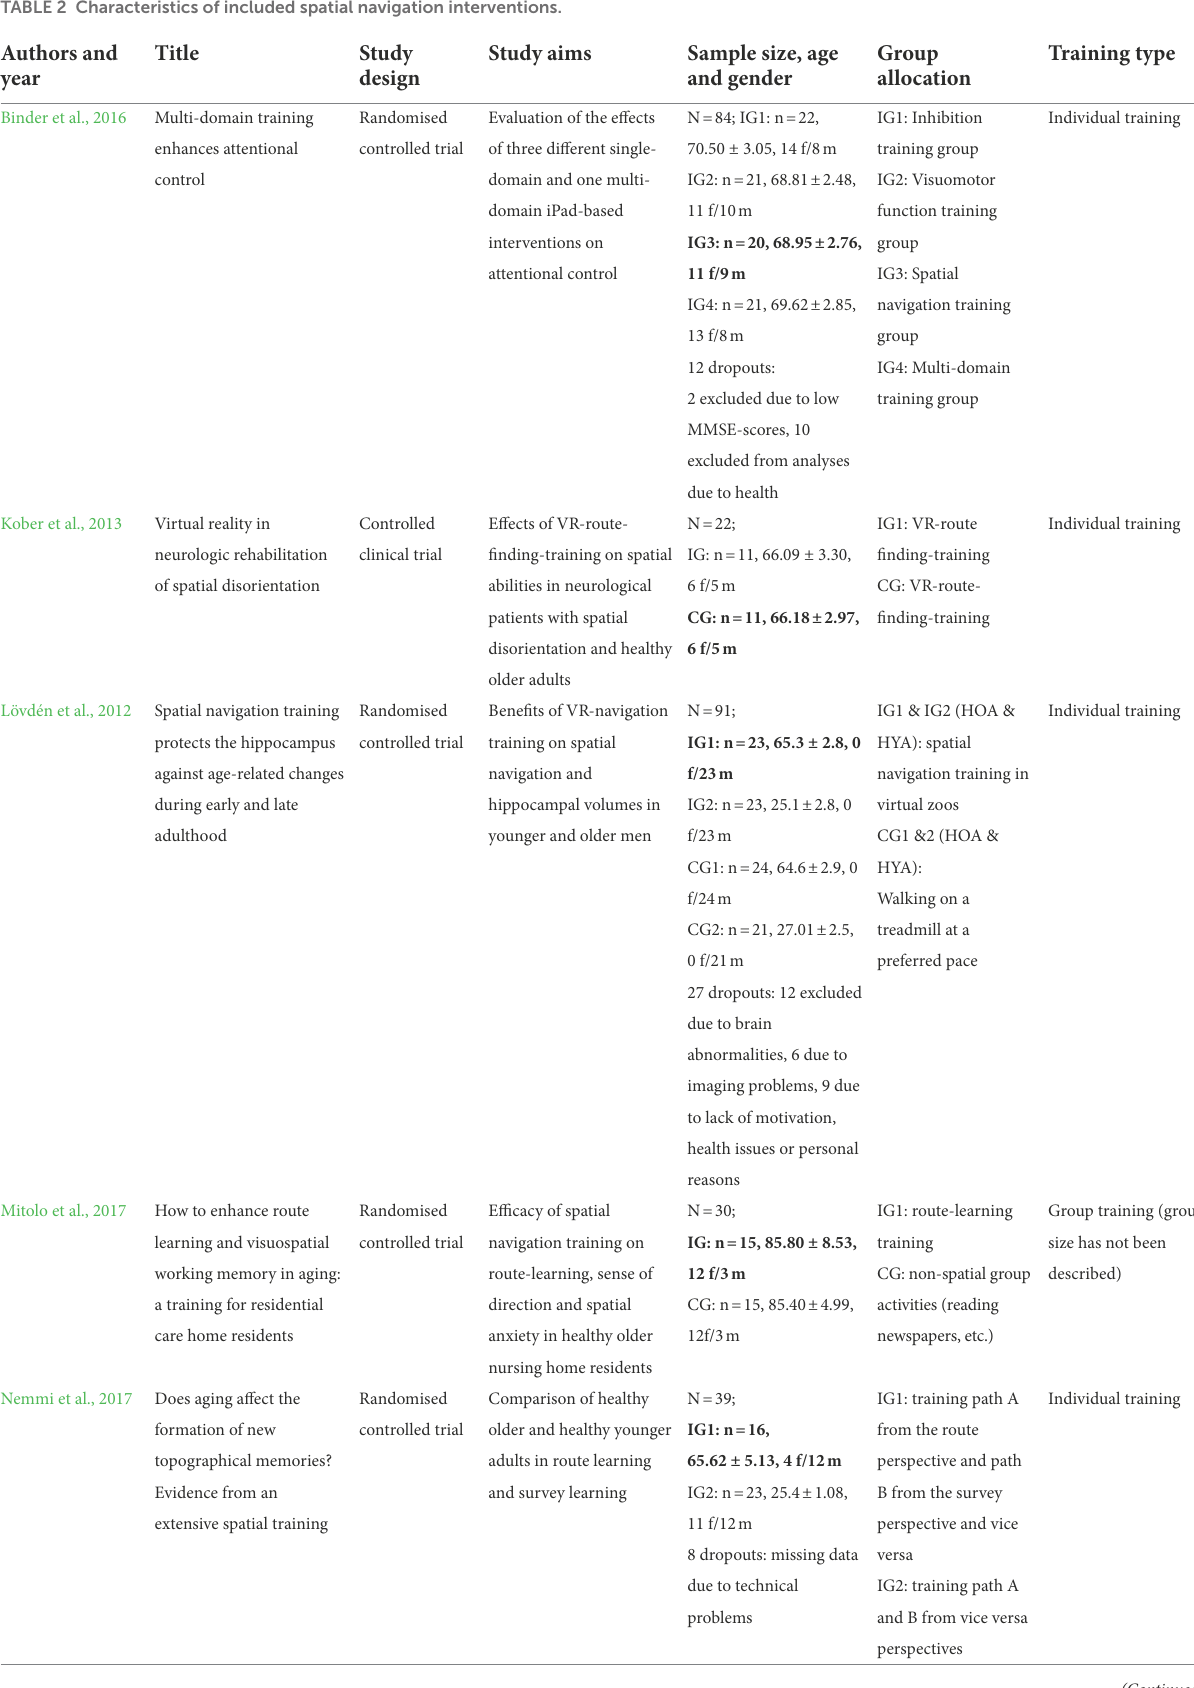
TABLE 2 Characteristics of included spatial navigation